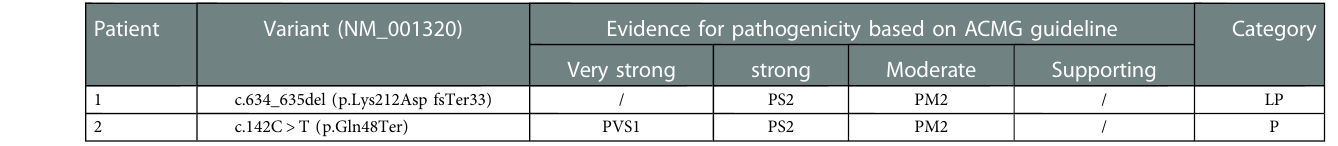
TABLE 1 Clinical interpretation of variants detected in CSNK2B by ACMG